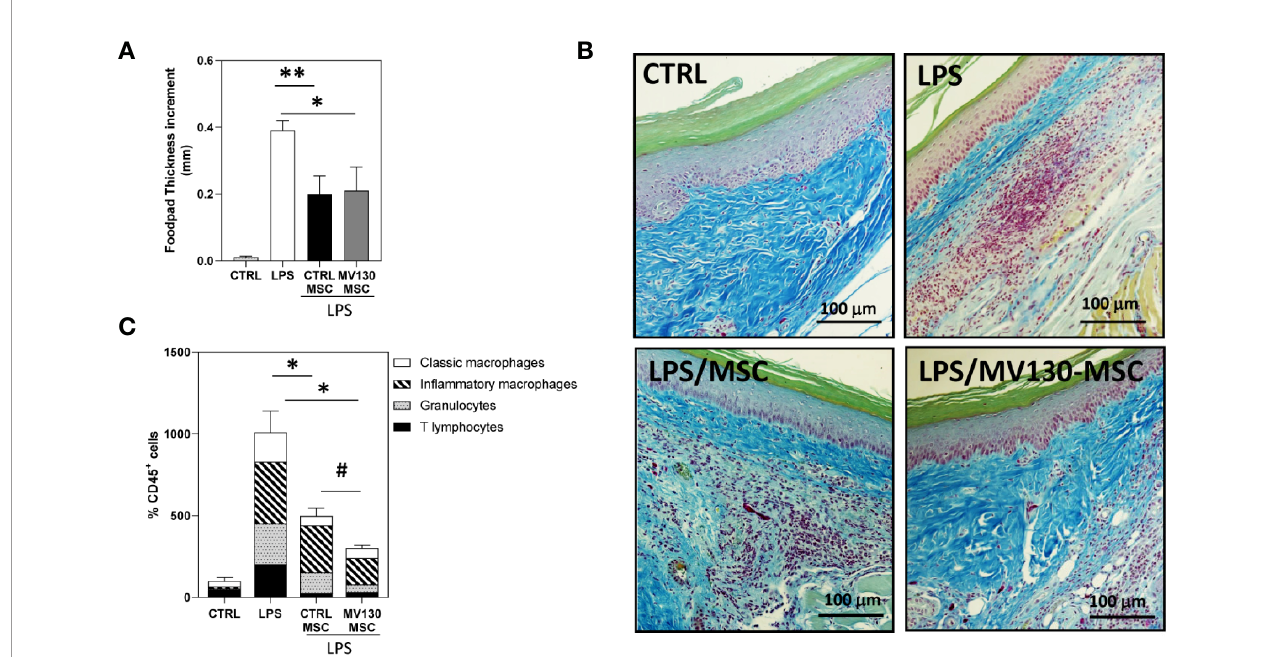
FIGURE 5 | Effects of MV130-MSCs in an in vivo model of acute in fl ammation. FVB/NJ mice were challenged in the footpad with 40 m g of LPS and administered with or without control or MV130-primed MSCs 24 h later. (A) Footpad thickness increment was determined after 72 h as a measure of the ef fi cacy of the different experimental groups of MSCs. Data shown are mean ± SEM of two independent experiments (three mice per group) (B) Images show histological sections of footpad tissue stained with Gallego ’ s Trichrome. Images are representative of 3 mice per group. (C) Percentage of CD45 + leukocytes in fi ltrating footpads in the different mouse groups analyzed by fl ow cytometry. The distribution of the different leukocyte subpopulations in CD45 + cells is also shown in each experimental group. Results represent increments relative to control animals (2 independent experiments with 3 mice per group) (*p < 0.05,**p < 0.01 versus LPS alone; # p < 0.05 versus CTRL-MSCs; by Wilcoxon